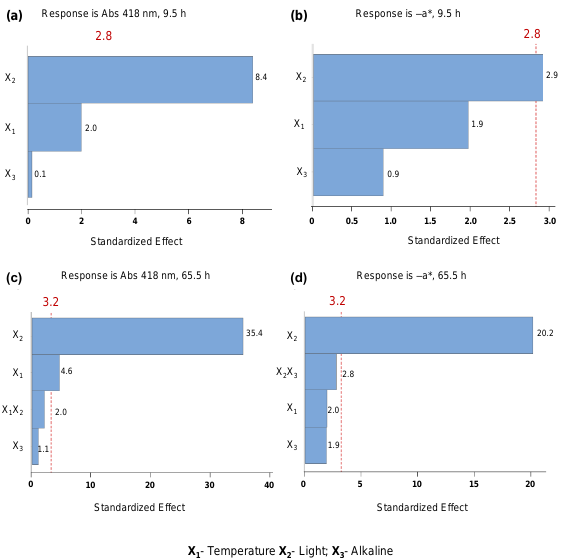
Figure 7. Pareto charts of the standardized effects: ( a ) response is Abs (418 nm), 9.5 h ( p < 0.05); ( b ) response is the value of greenness ( − a*), 9.5 h ( p < 0.05). Pareto charts of the standardized effects: ( c ) response is Abs (418 nm), 65.5 h ( p < 0.05); ( d ) response is − a*, 65.5 h ( p < 0.05).